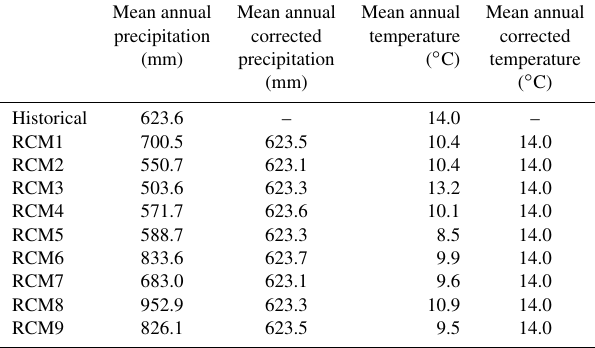
Table 2. Mean annual values of precipitation and temperature for the historical and the RCM simulations (and corrected RCM simu- lations) in the reference period